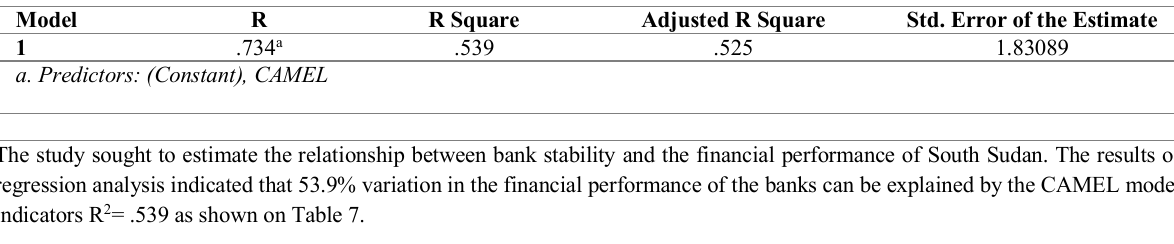
Table 8: ANOVA for Bank Stability and Financial Performance